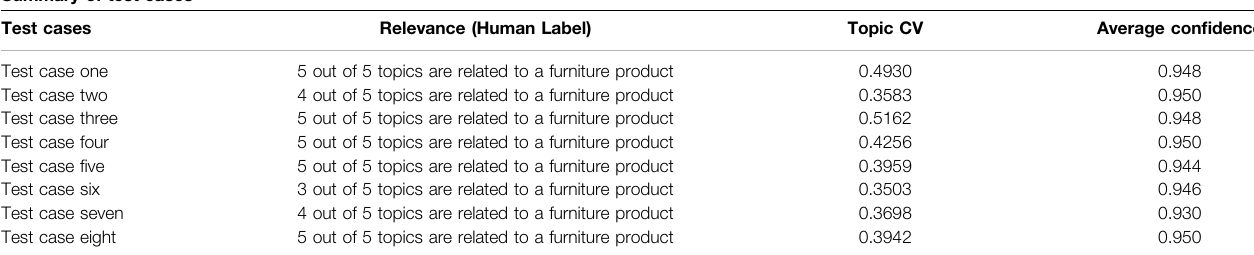
TABLE 5 | Summary of test cases.